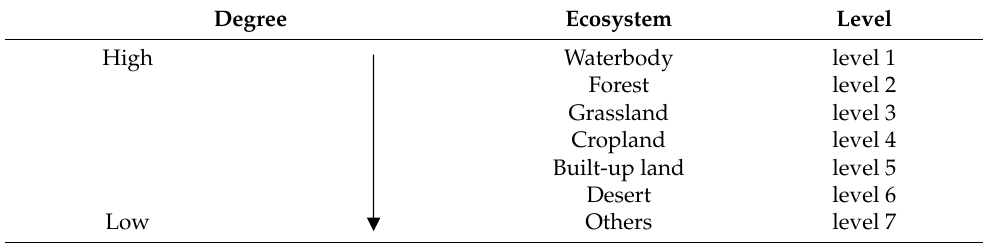
Table 3. Classification standard of various ecosystems.